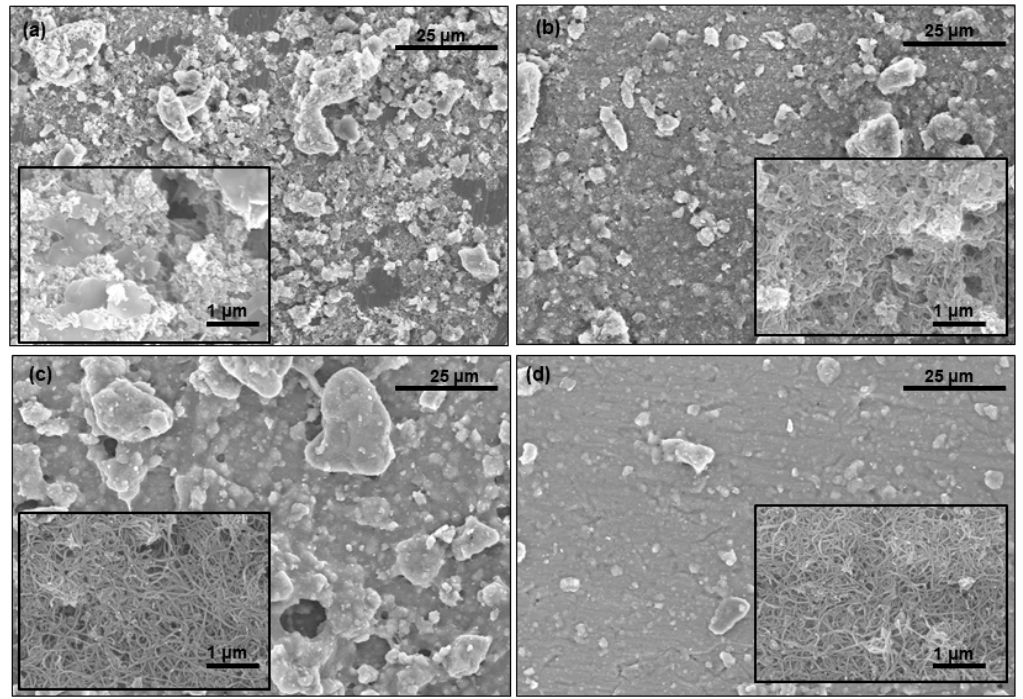
Figure 3. FE-SEM image of the MWCNTs-HA composites with various MWCNT contents ( a ) 0 wt %, ( b ) 0.1 wt %, ( c ) 0.5 wt % and ( d ) 1 wt %.